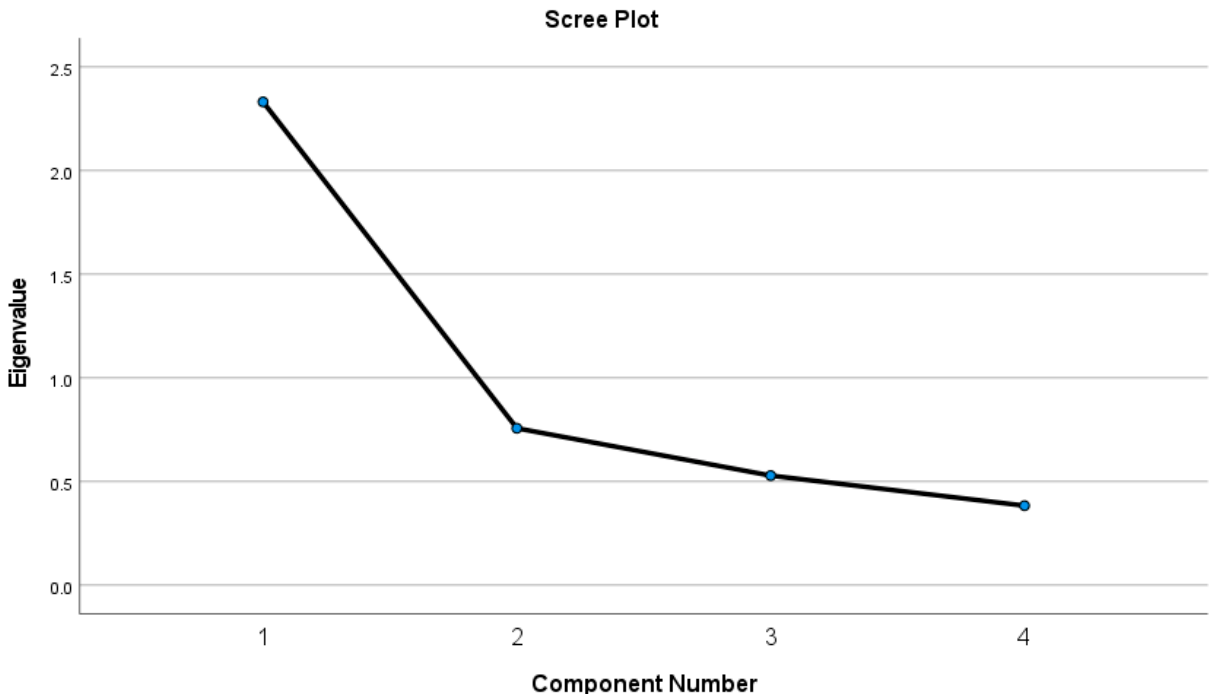
Figure 6. Scree plot in the principal component analysis regarding units responsible for the implementation process. Based on the Kaiser criterion, only one component was extracted. According to the value of the independent samples t-test there was no statistically significant difference between larger and smaller companies regarding the total responsibility score t (58) =